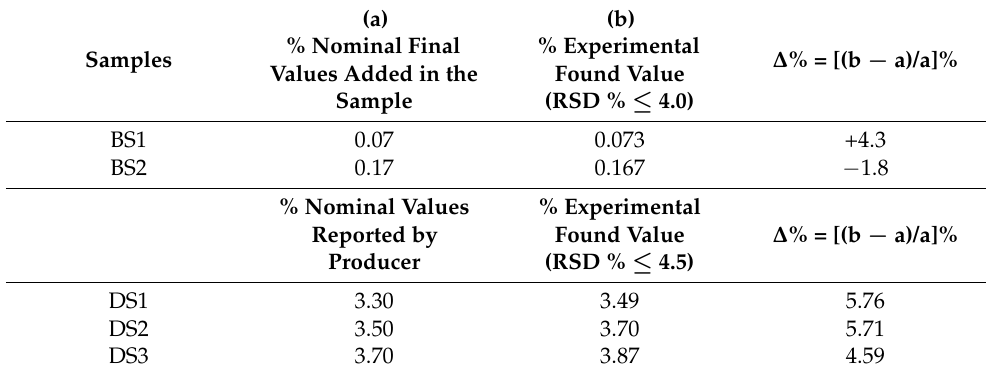
Table 2. Results of ethanol determination in real samples: two human saliva (named BS1 and BS2) and three diluted (1:20) disinfectant solutions (named DS1, DS2, and DS3). (a) (b) % Nominal Final % Experimental ∆ % = [(b − a)/a]% Samples Values Added in the Found Value Sample (RSD % ≤ 4.0) BS1 0.07 0.073 +4.3 BS2 0.17 0.167 − 1.8 % Nominal Values % Experimental ∆ % = [(b − a)/a]% Reported by Found Value Producer (RSD % ≤ 4.5) DS1 3.30 3.49 5.76 DS2 3.50 3.70 5.71 DS3 3.70 3.87 4.59 BS = Biological Sample (human saliva), DS = Disinfectant